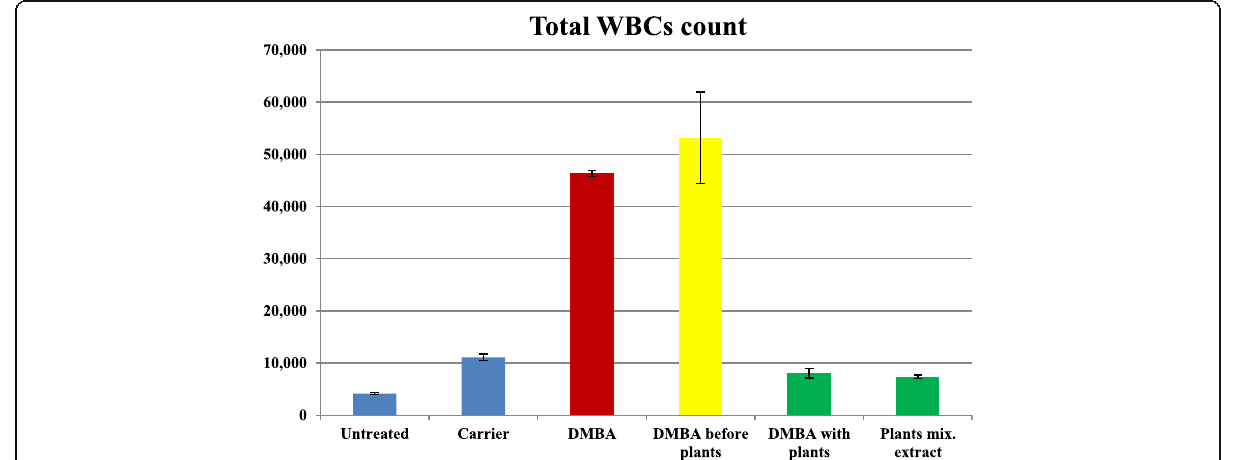
Fig. 2 Total WBC count in the different rat groups. Standard errors are indicated on the bars and the significance levels are shown in Table 1